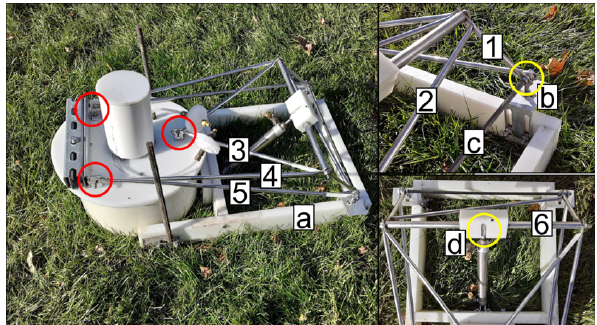
Figure 3. Image of chamber design: HDPE base (a) , aluminum L bracket (b) , threaded rod (c) , and pneumatic cylinder rod end (d) . The length of each numbered stainless-steel tube is as follows: 1 (16cm), 2 (47cm), 3 (41cm), 4 (56cm), 5 (65cm), and 6 (18cm). The yellow circles indicate points of rotation while red circles de- note rigid, fixed connection